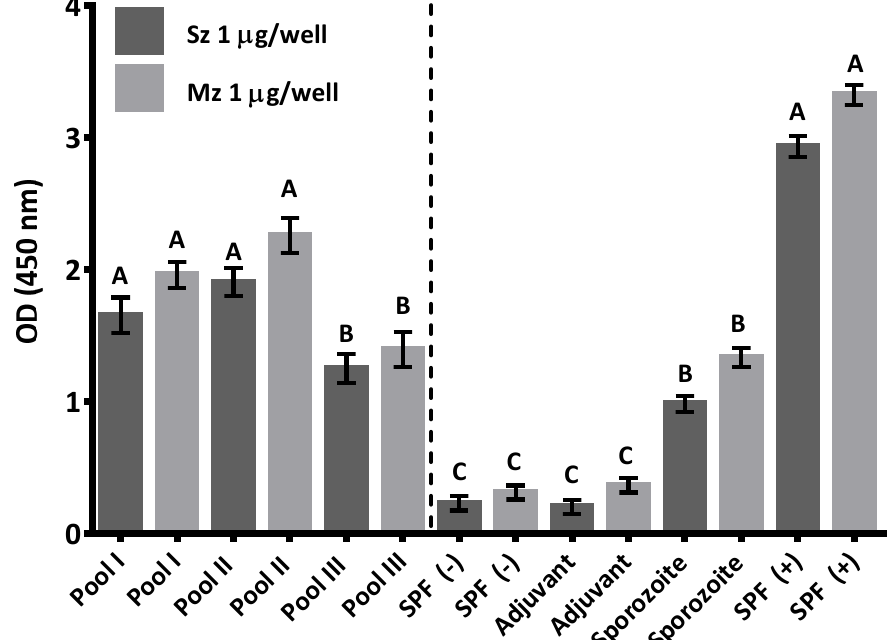
Figure 1. Mean avidity of sera against sporozoite (Sz) and merozoite (Mz) antigens in SPF chicks at 3 days of age (Pool I, II, and III) and antibody response at 21 days of age in the chicks immunized with whole sporozoites of E. tenella , chicks mock-injected, unimmunized SPF birds ( − ), and positive reference sera (+). Bars represent mean OD ( ± SD). Different letters (A, B, or C) in sporozoite or merozoite antigens of E. tenella indicate statistical differences at p < 0.05.